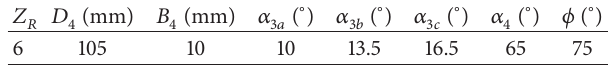
Table 2: Design parameters of